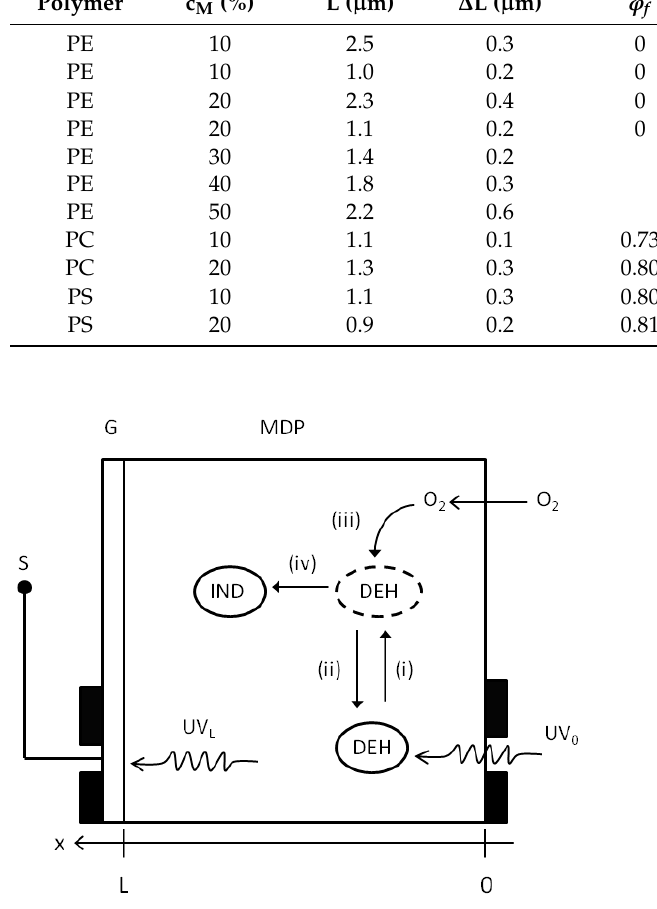
Figure 1. Experimental configuration used to perform UV absorption measurements on MDP films of thickness L. UV 0 and UV L are, respectively, the incident UV intensity at the film surface and transmitted through the film thickness. The internal photo-cyclic oxidation processes for DEH are indicated according to processes (i)–(iv) described in the discussion section. G = glass substrate, S = spectrometer.